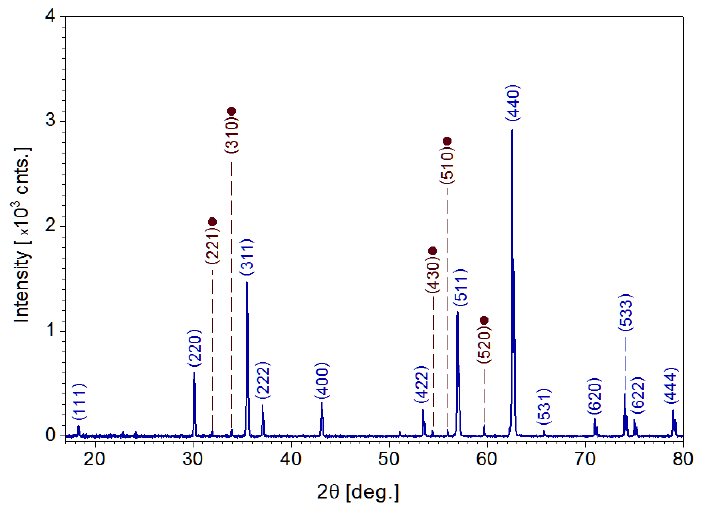
Figure 3. The XRD record of the microcrystal powder.